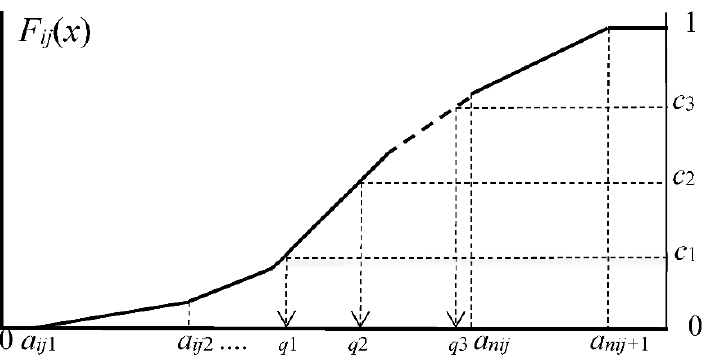
Figure 1. Cumulative distribution function and cut point probabilities.